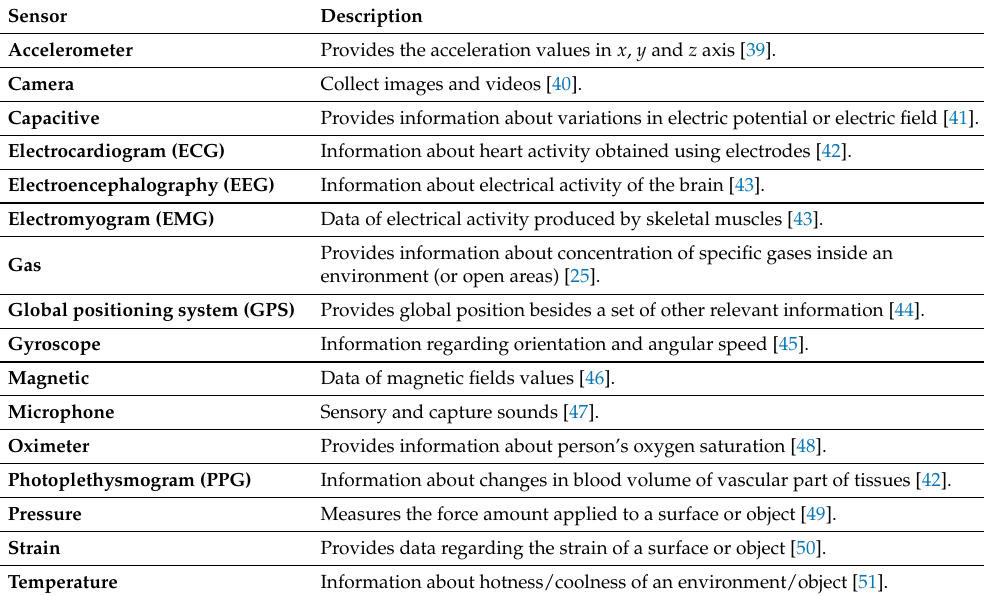
Table 1. Common sensors used by